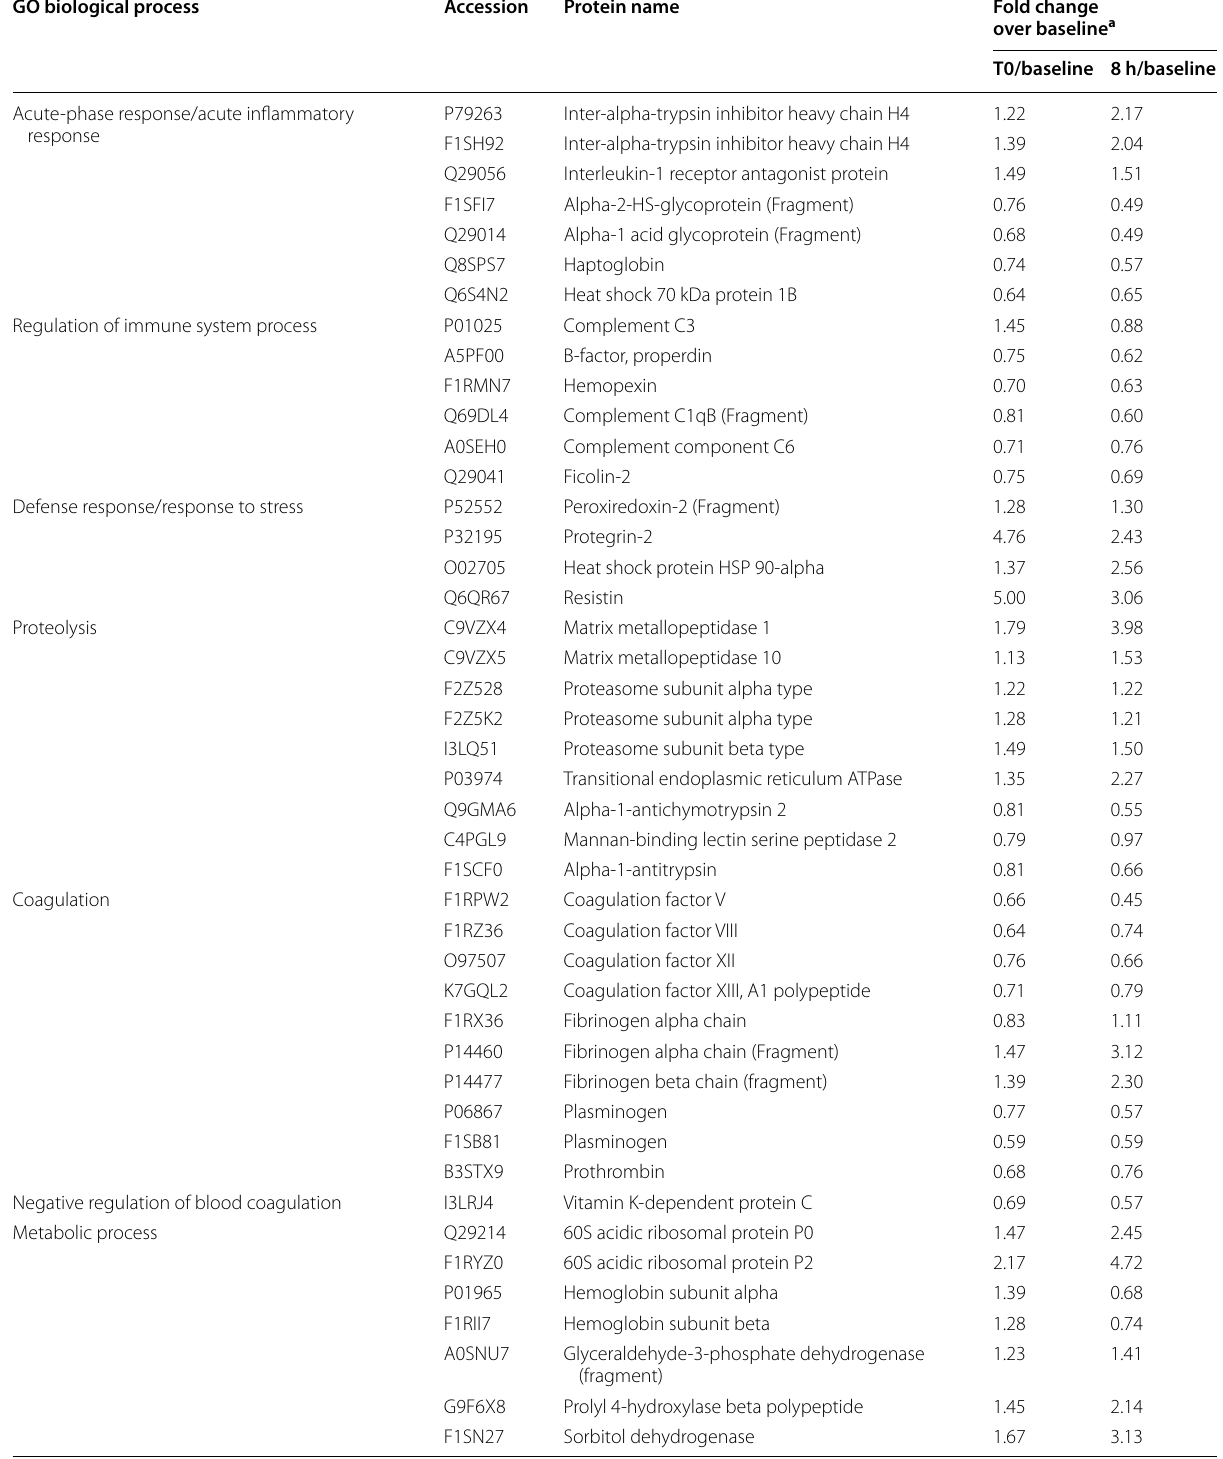
Table 5 Ontology groups and associated differentially expressed plasma proteins in the time points of T0 and 8 h after HA-sham treatment versus